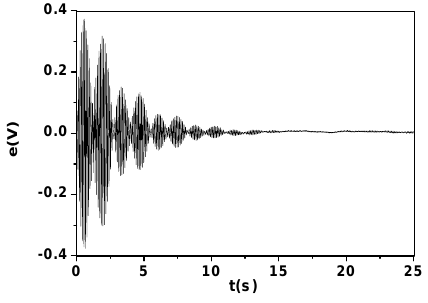
Fig. 4. Error evolution – LMS algorithm applied to case C 1 .